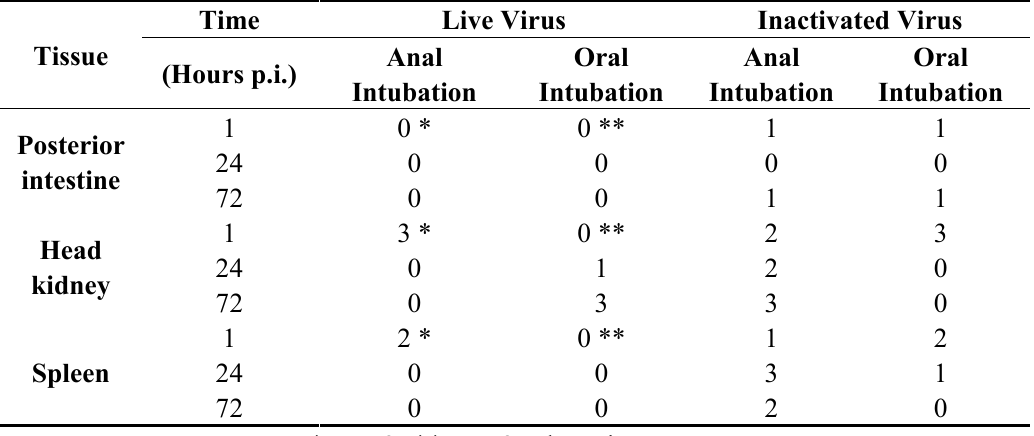
Table 1. Number of fish with positive staining for infectious pancreatic necrosis virus antigens in different tissues following intubation.